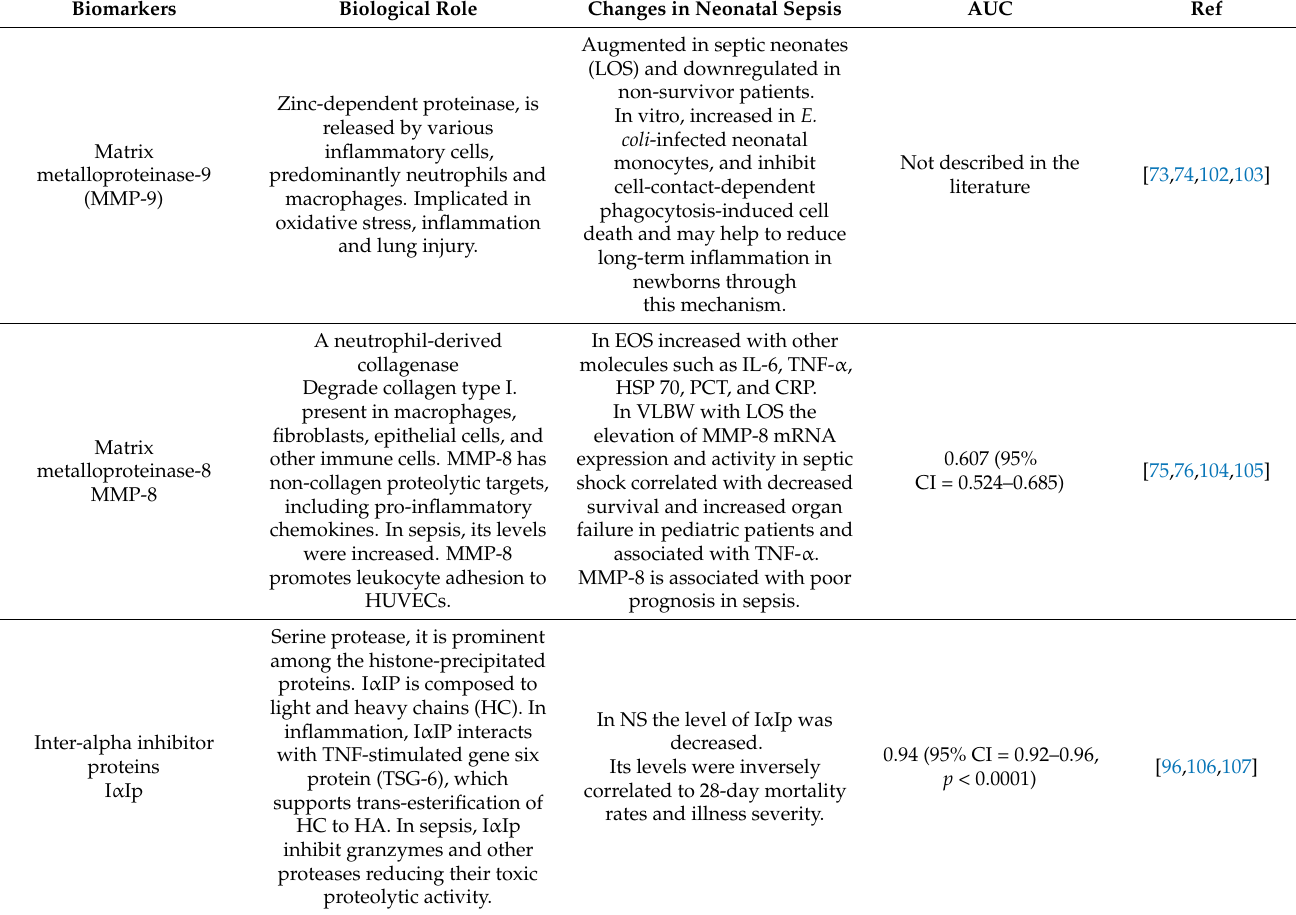
Table 1. Potential biomarkers of the endothelial glycocalyx in neonatal